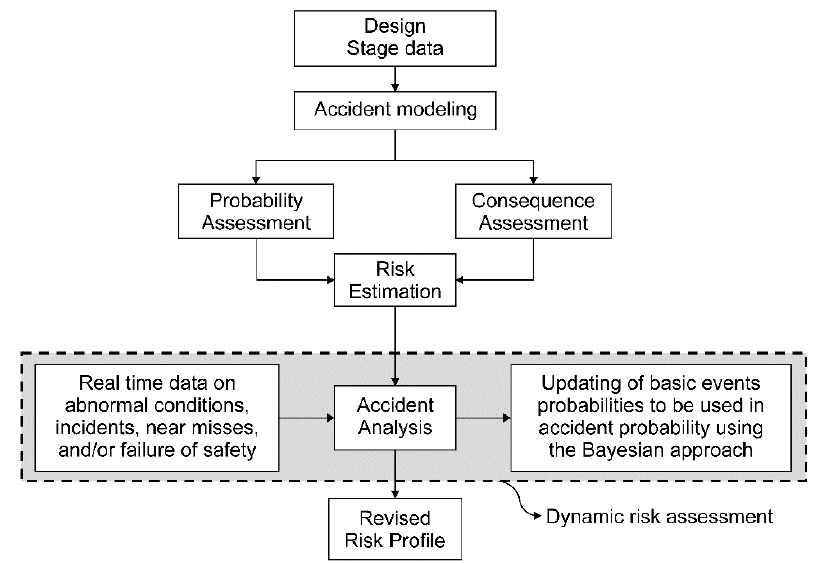
Figure 1. Dynamic risk assessment methodology [2,11].